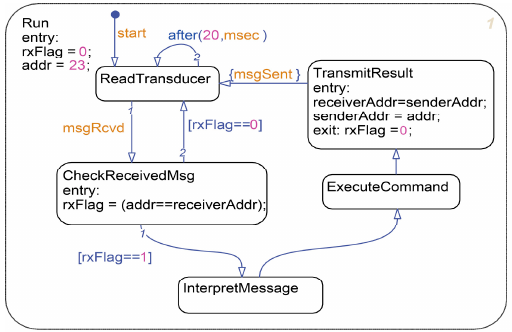
Figure 8. Sensor state machine (addr-address on the bus, msgRcvd/msgSent-message received/sent